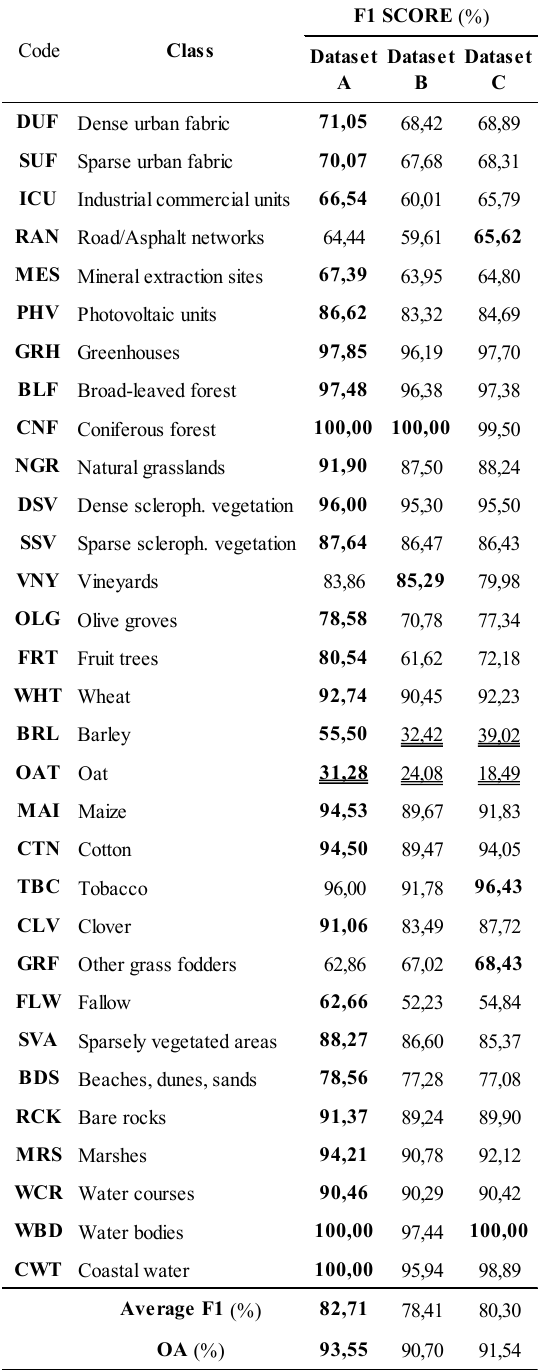
Table 1. OA and per class F1 rates for the RF experiments on Datasets A, B and C. Highest rate per row is marked with bold and low rates (<40%) with double